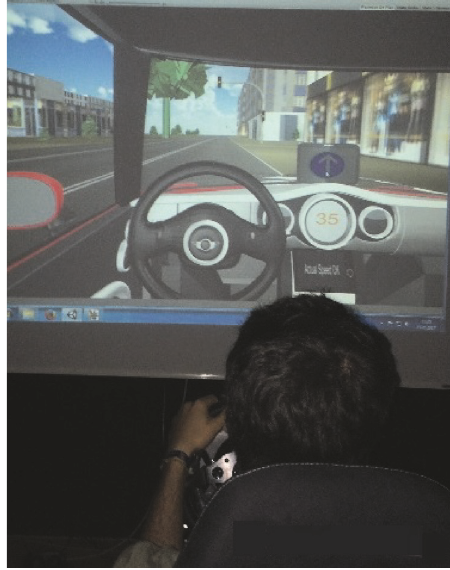
Figure 4: Participant performing experiment with TLA system